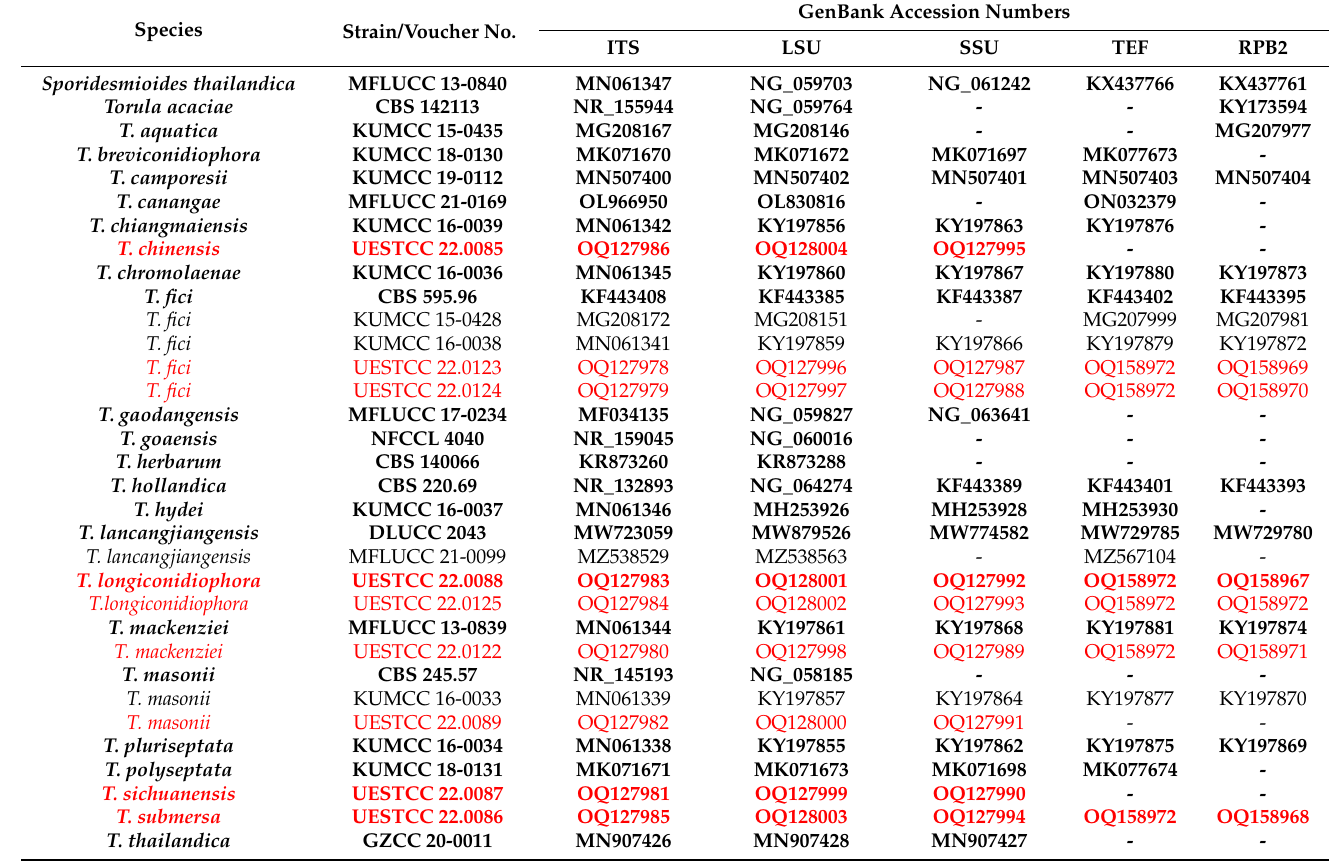
Table 2. Species details and their GenBank accession numbers used in phylogenetic analyses. Type/epitype strains are in bold, and newly generated sequences are in